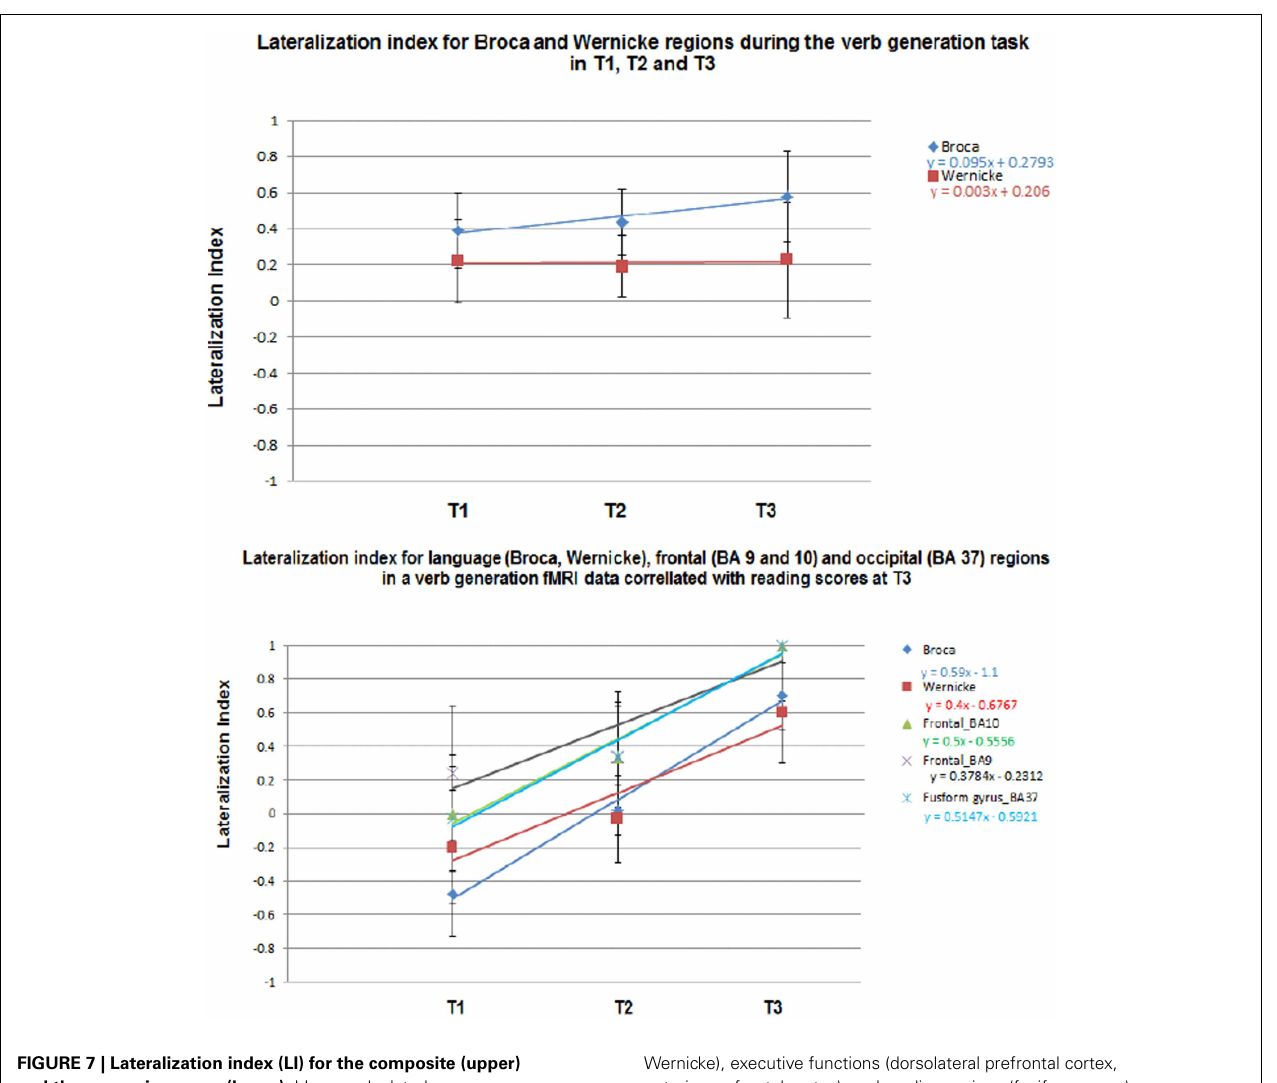
FIGURE 7 | Lateralization index (LI) for the composite (upper) and the regression maps (lower). LI was calculated on language-related regions (Broca andWernicke) in the composite maps inT1–T3. LI was also calculated on language (Broca and